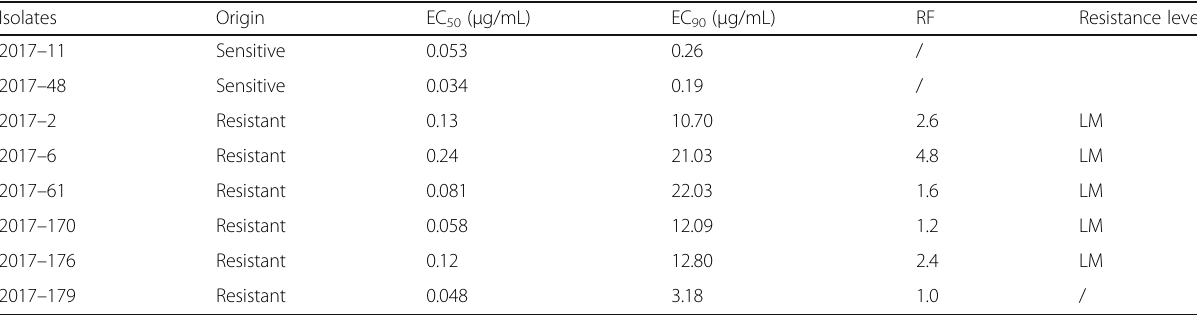
Table 2 Sensitivity of the preliminarily screened resistant isolates of Ustilaginoidea virens to propiconazole